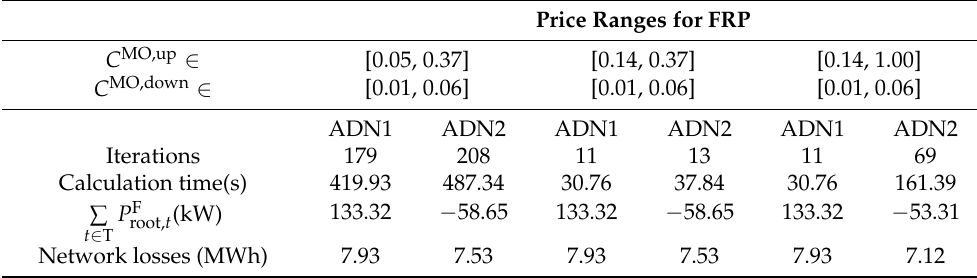
Table 2. Comparison of optimizations under different price ranges.